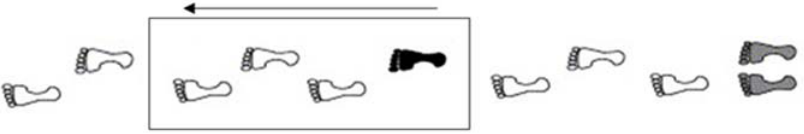
Figure 3. Scheme of the mid ‐ gait protocol (developed based on the available sources).